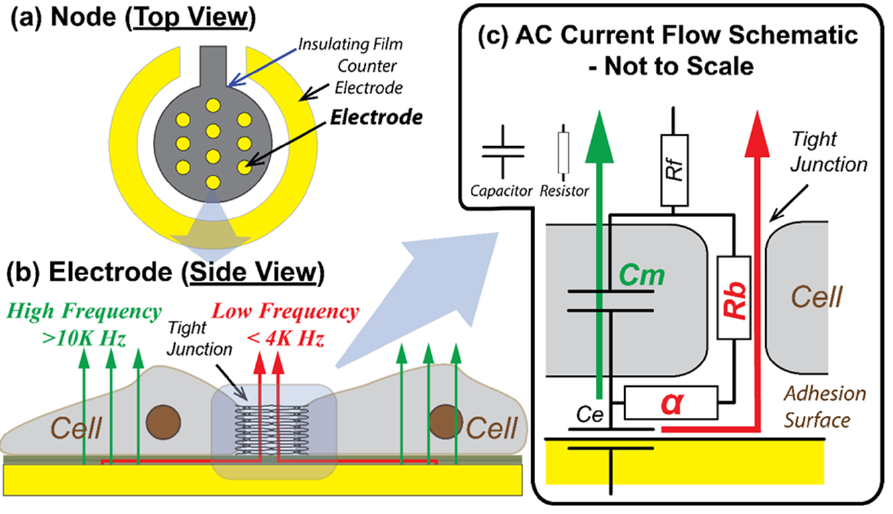
Figure 3. Schematics of ECIS electrode configuration and AC current flow paths (not to scale, based on [12,17]). ( a ) The node consists of 10 electrodes, each of which has a diameter of 250 µm providing the surface area to be covered with 100–1000 cells. ( b ) At relatively low frequencies (<2 kHz) most of the current flows under and between adjacent cells (through tight junctions), and at higher frequencies (>20 kHz) more current passes directly through the insulating cell membranes [23]. ( c ) An explanatory simplified electrical circuit to demonstrate the impedance modeling parameters in the current flows through and around cells. The modeling parameters of basal adhesion function ( α ) and intercellular barrier function ( Rb ) are represented as resistors, since both parameters are dependent on the binding and the electrical pathway gap. Cell membrane capacitance ( Cm ) is dependent on the composition of the cell membrane. Ce is the electrode capacitance and Rf is the resistance of the growth media. In the current study, we use resistance at frequency 1 kHz, R (1K), to monitor the formation of cell–cell tight junction, and capacitance at 64 kHz, C (64K), to monitor the formation of confluent cell layer on electrodes.